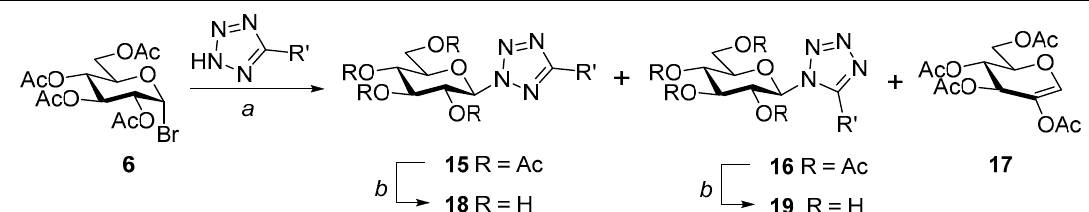
Molecules 2017 , 22 , x FOR PEER REVIEW Table 4. Synthesis of N -( β - D -glucopyranosyl)-5-substituted-tetrazoles. Table 4. Synthesis of N -( β - D -glucopyranosyl)-5-substituted-tetrazoles.